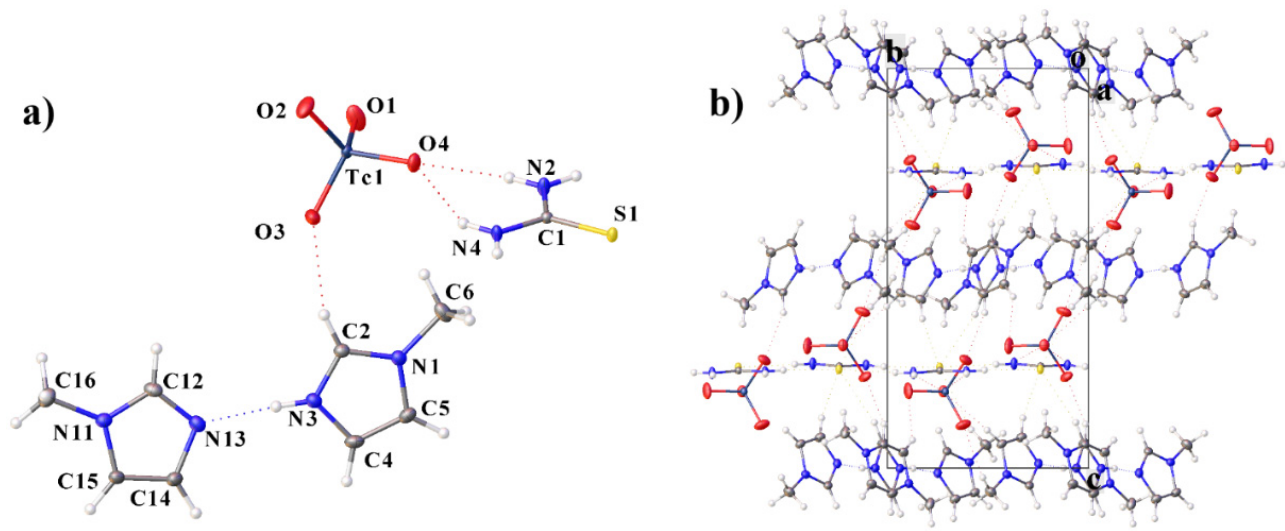
Figure 4. Molecular structure of V ( a ) including atom labeling and crystal packing ( b ). Only one disordered H-atom of the imidazole ring is shown. Table 2. Absorption peaks of compound II in the IR spectrum. Peak Position